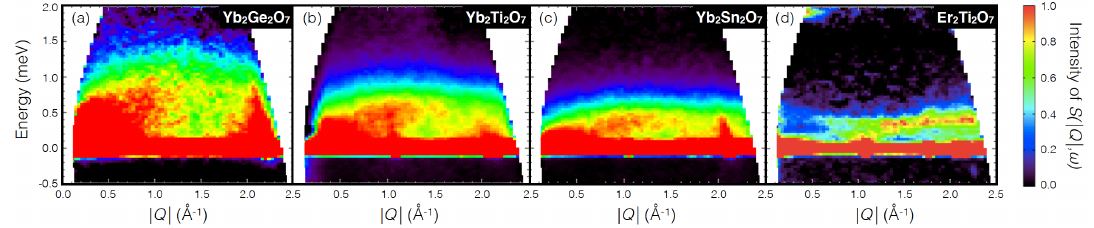
Figure 13. (color online) Inelastic neutron scattering spectrum for ( a ) YGO, ( b ) YTO, ( c ) YSO, and ( d ) ETO. From Ref.